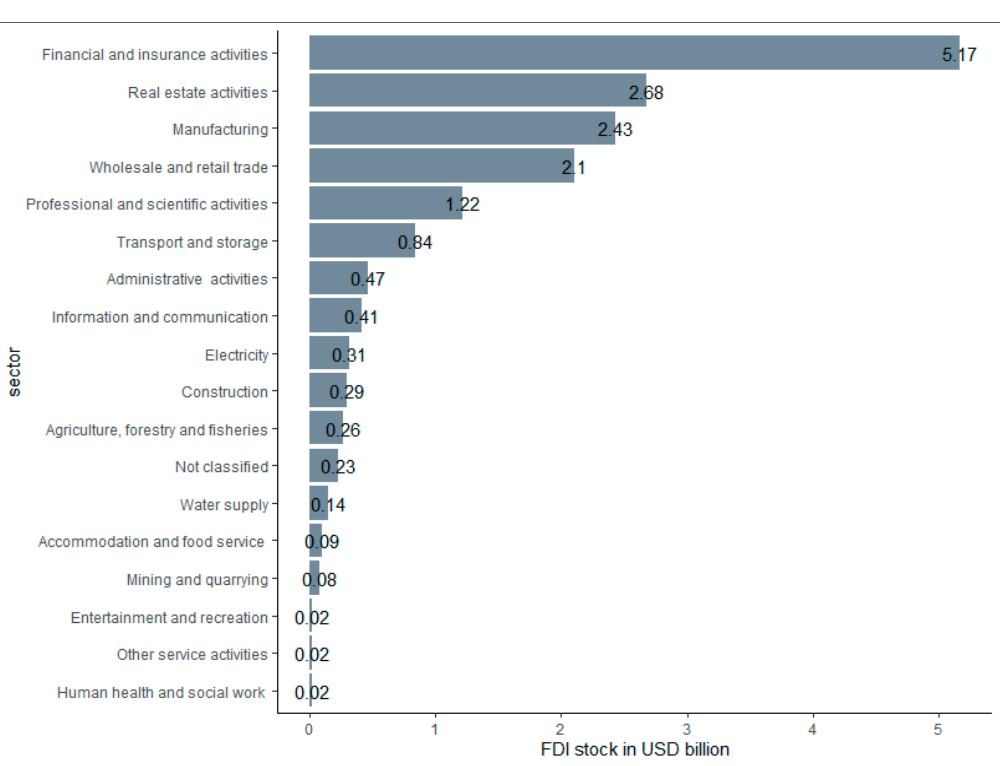
Figure A1. Average inward FDI stocks in economic sectors of Estonia across 2004–2017.